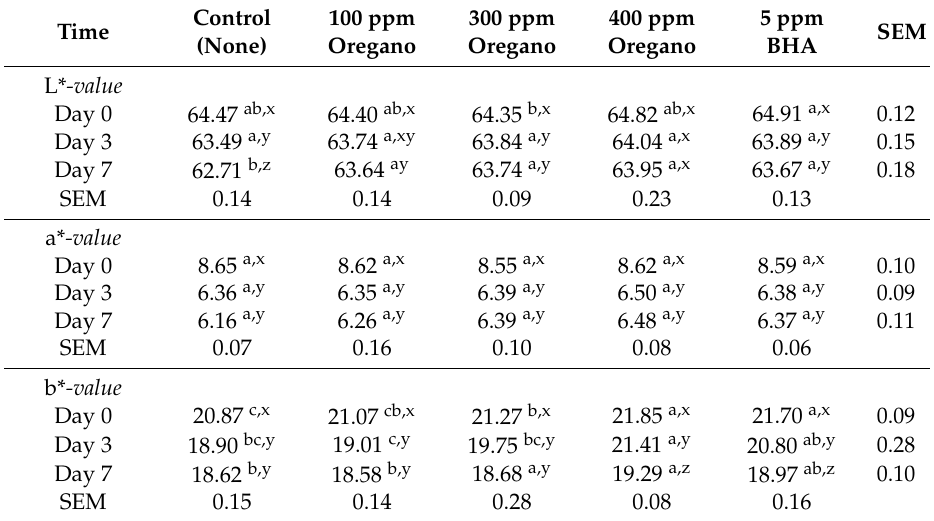
Table 3. CIE Color values of raw chicken breast meat with different levels of oregano oil during storage at 4 ˝